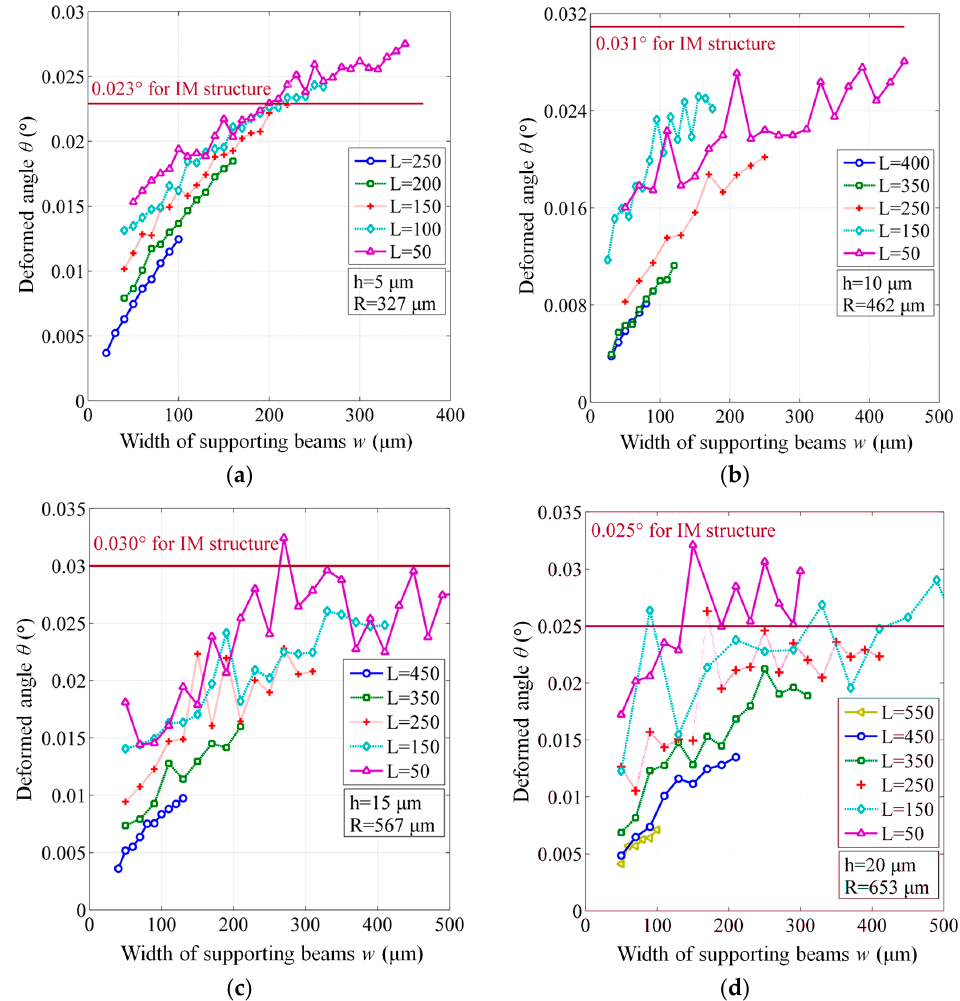
Figure 7. Flatness of BSM structures for different geometrical dimensions, compared to the constant values of IM structures. ( a ) Membrane thickness h = 5 μ m and radius R = 327 μ m; ( b ) h = 10 μ m and R = 462 μ m; ( c ) h = 15 μ m and R = 567 μ m; ( d ) h = 20 μ m and R = 653 μ m.